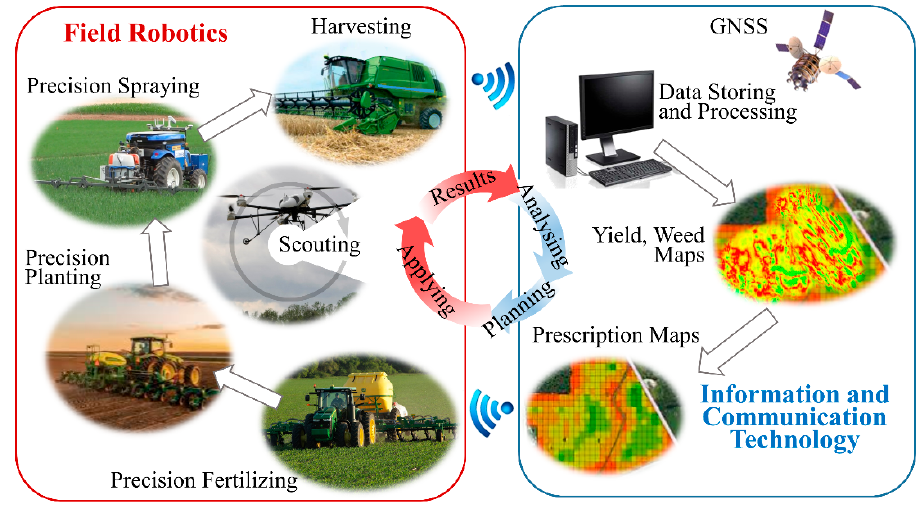
Figure 1. Technologies involved in precision agriculture.